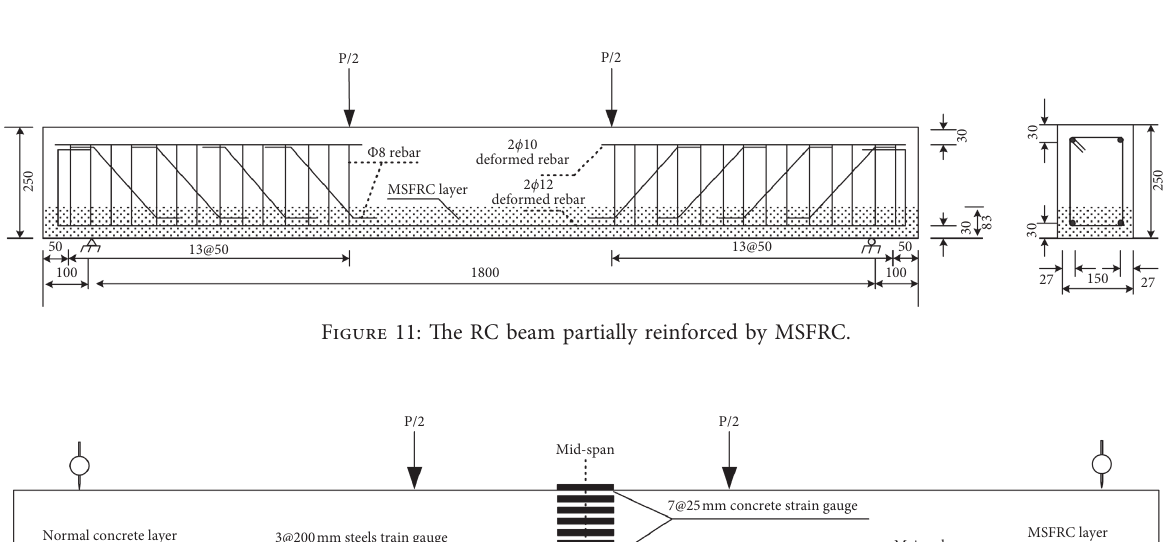
Figure 10: Crack-retarding and strengthening mechanism of the RC beam partially reinforced by MSFRC.